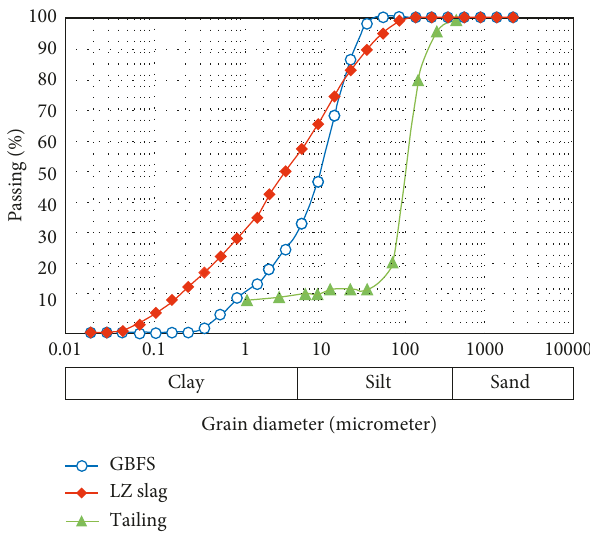
Figure 1: Grain size distribution curve of the tailing material